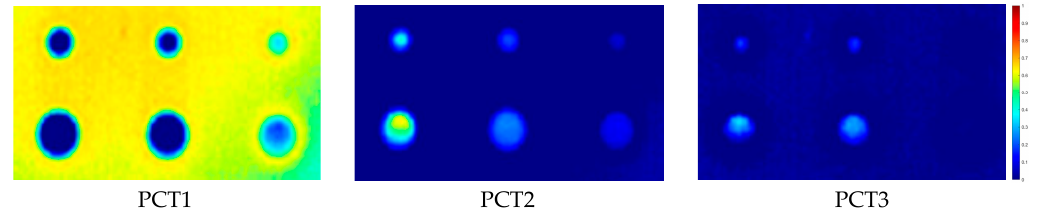
Figure 10. Surface temperature curves of different defect depth: ( a ) diameter is 16 mm; ( b ) diameter is 10 mm.